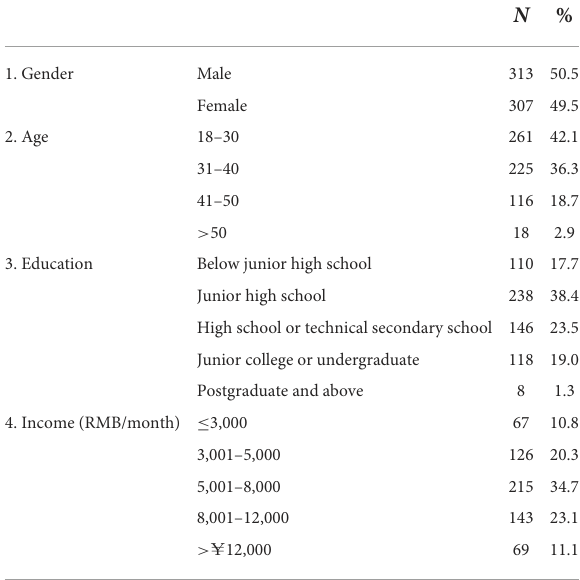
TABLE 1 Demographics of respondents ( N =